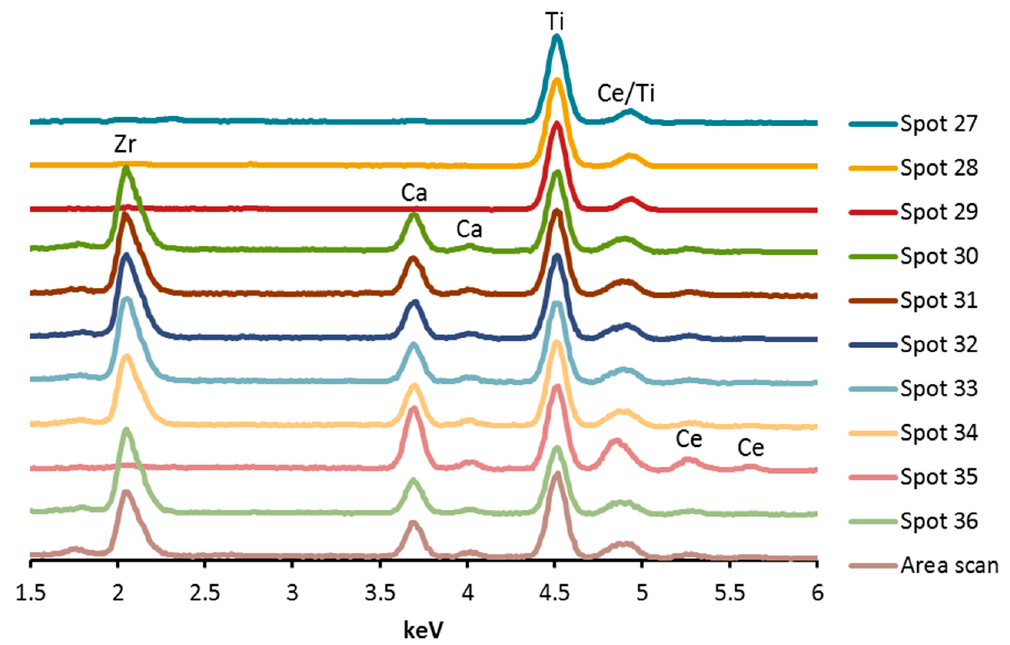
Figure 4. Energy dispersive X-ray spectroscopy (EDX) spectra of spots analysed in the bottom half of Figure 2.